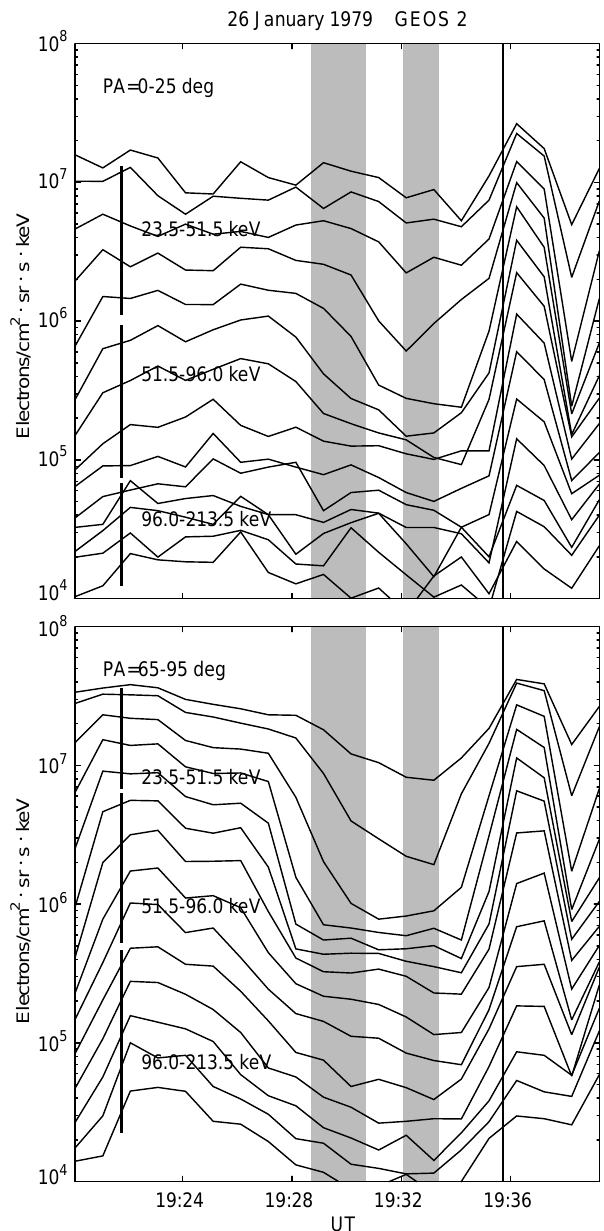
Fig. 5. Di(cid:128)erential electron flux recordings by GEOS 2 (for satellite location see the previous figure caption) around the auroral fadings on 26 January 1979: ( upper panel ) electrons with pitch angles 0–25 (cid:14) , and ( lower panel ) and with pitch angles 65–95 (cid:14) . The gray shadings show the fading times, and the thin vertical solid line marks the time of the auroral breakup. The energy channels are (from top to bottom):